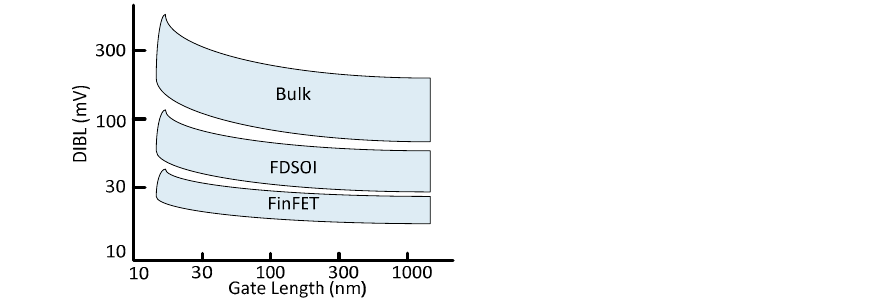
Figure 16. DIBL in bulk fully depleted silicon on insulator (FDSOI) and FinFET [54].